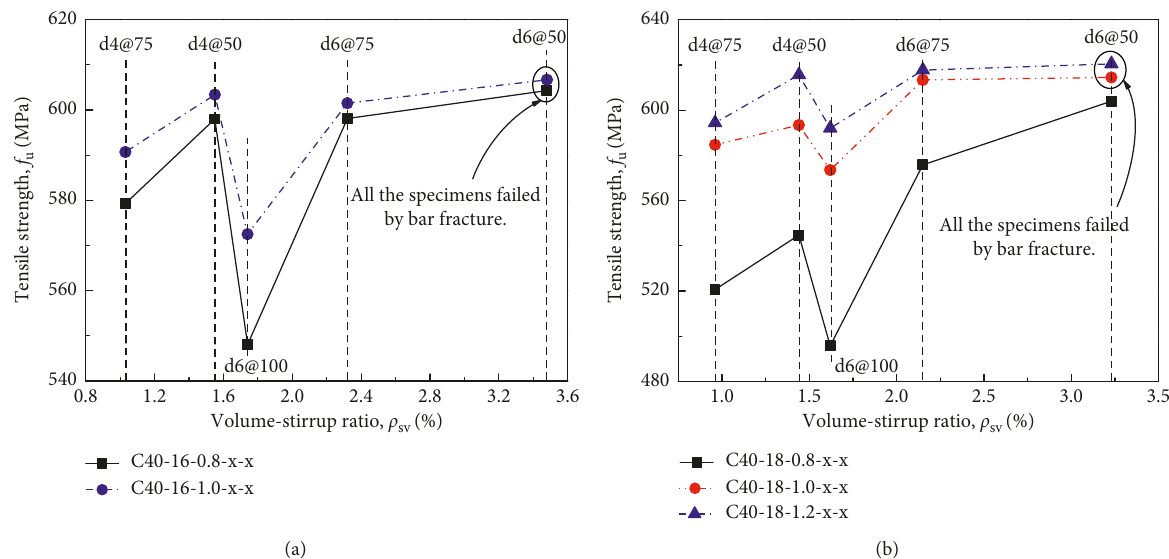
Figure 7: Tensile strength-volume stirrup ratio relationship: (a) d16; (b)